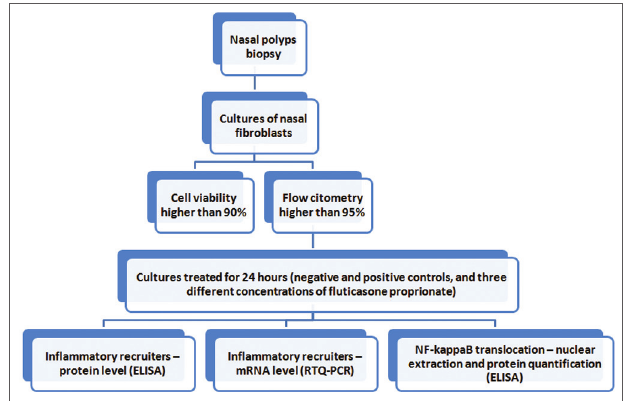
Figure 1. Fluxogram of the study protocol Cell